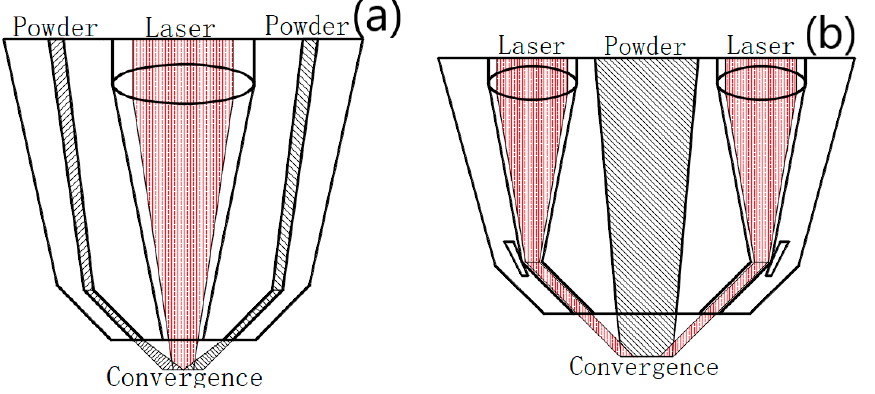
Figure 1. Schematic diagram of typical two feeding methods. ( a ) Laser outside powder feeding; ( b ) laser inside powder feeding. ( b ) laser inside powder